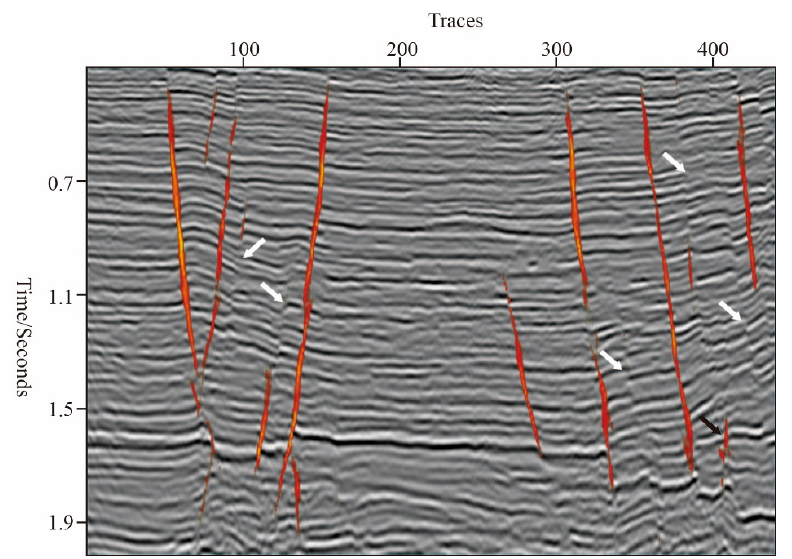
Figure 4. A 2D seismic section is displayed with the fault probability predicted by the pre-trained